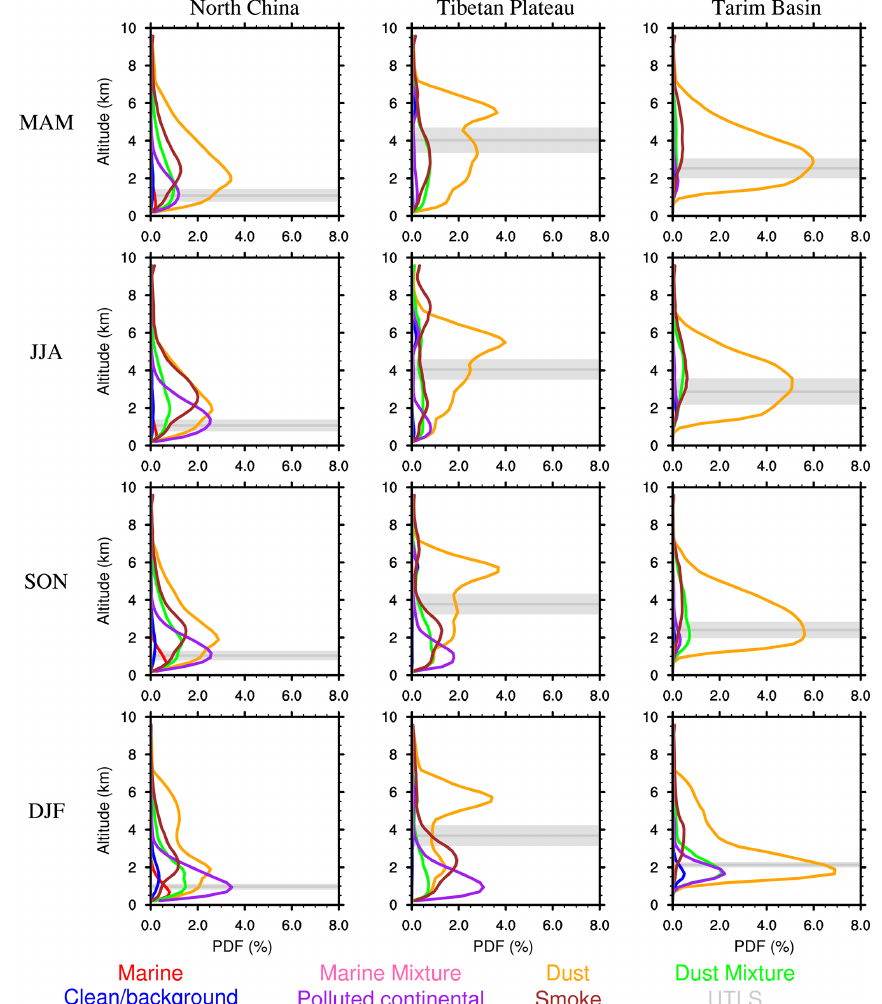
Figure 3. Probability distributions (frequency of occurrence) of the CATS-derived vertical aerosol subtypes by season over the three regions. The gray lines and filled areas correspond to the height of the regional mean planetary boundary layer (km) from the NCEP FNL reanalysis data and 1 standard deviation of the seasonal average,